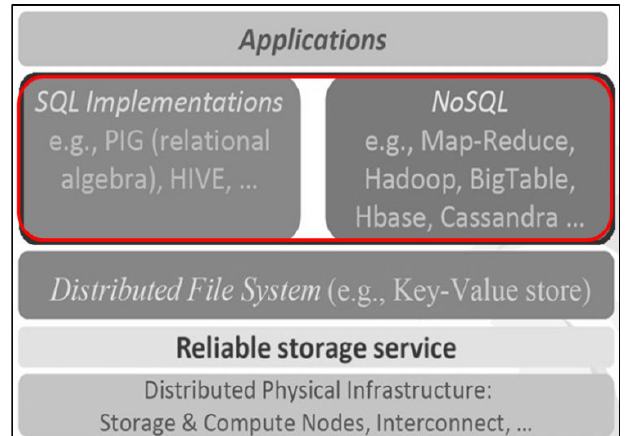
Figure 1. The new stack of Cloud